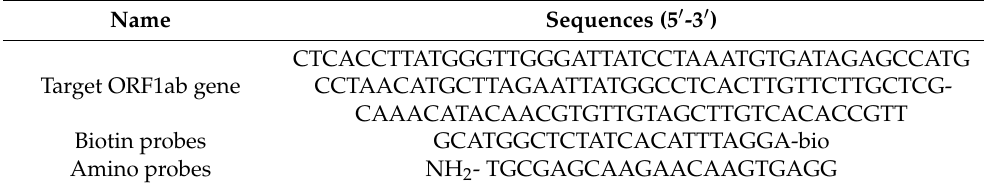
Table 1. Target gene and probes’